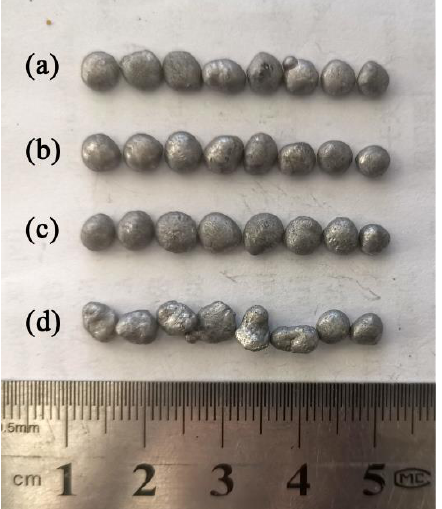
Figure 16. Droplets collected from the physical simulation at different filling rates. ( a ) filling rate = 0.5; ( b ) filling rate = 0.6; ( c ) filling rate = 0.7; ( d ) filling rate = 0.8. ( b ) filling rate = 0.6; ( c ) filling rate = 0.7; ( d ) filling rate =